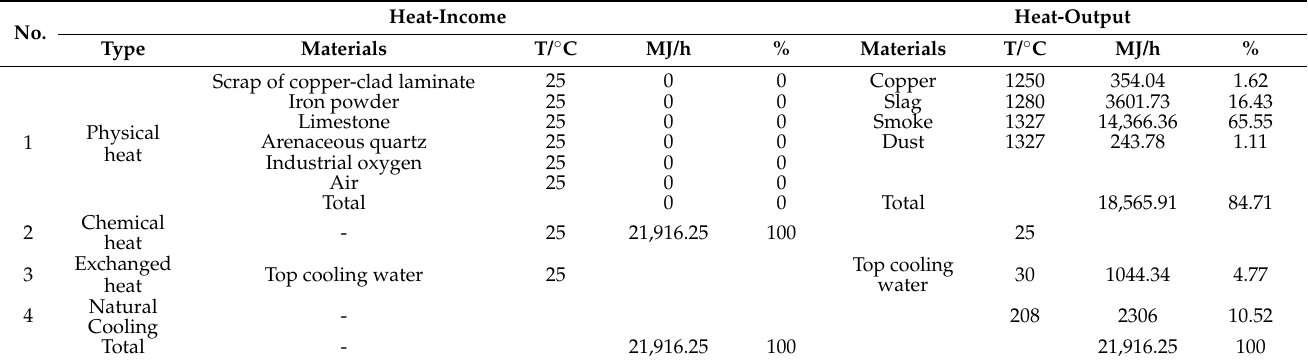
Table 4. The input-output heat balance of the NRT